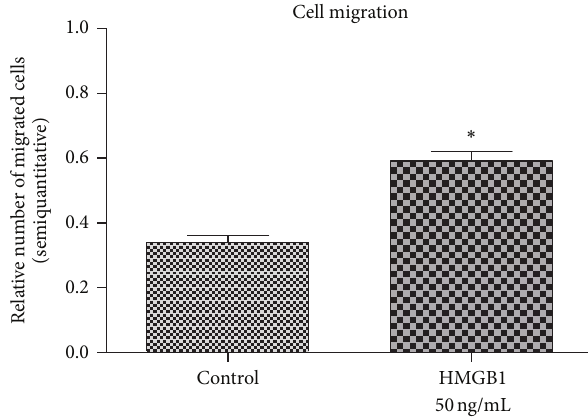
Figure 2: HMGB1 stimulates PDL cell migration. HMBG1 treat- ment of hPDL cultures resulted in a significantly higher number of cells migrating from the upper to the lower chamber of the transwell assay system. Data represent the mean ± SD for six independent cultures. ∗ 𝑃 < 0.05 , experimental group versus untreated control.